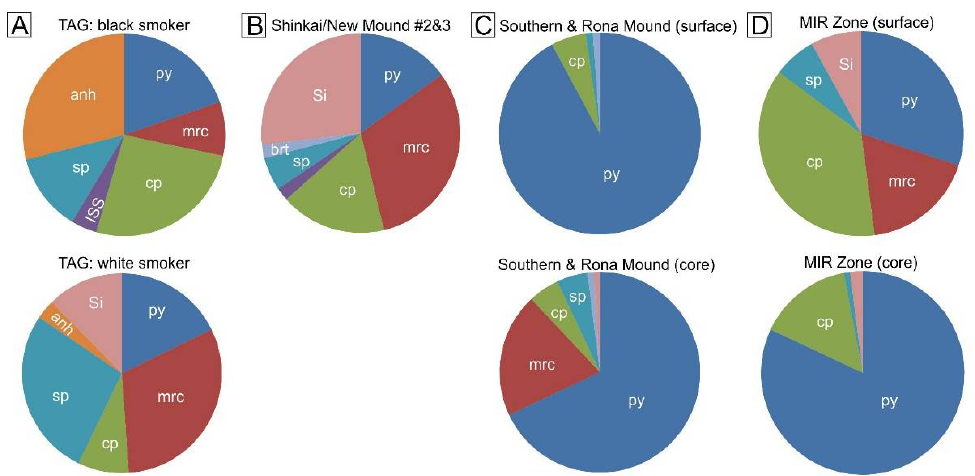
Figure 9. The relative abundance of major minerals observed in surface and sub-surface samples from the TAG area. ( A ) Typical minerals occurring in black and white smoker samples recovered from the active TAG mound, data from [18]. ( B ) Typical mineral assemblage in surface grab-samples from Shinkai Mound and New M. #2 & #3 obtained during Blue Mining cruise. ( C ) Composition of surface and subsurface samples from Southern Mound and Rona Mound obtained during Blue Mining cruise. ( D ) Typical mineral assemblage in surface (data from [12,28]) and sub-surface samples (data from Blue Mining cruise) from the MIR Zone. Mineral abbreviations: cp: chalcopyrite, ISS: isocubanite/cubanite, py: pyrite, mrc: marcasite, sp: sphalerite/wurtzite, anh: anhydrite, brt: barite, Si: amorphous silica/quartz.